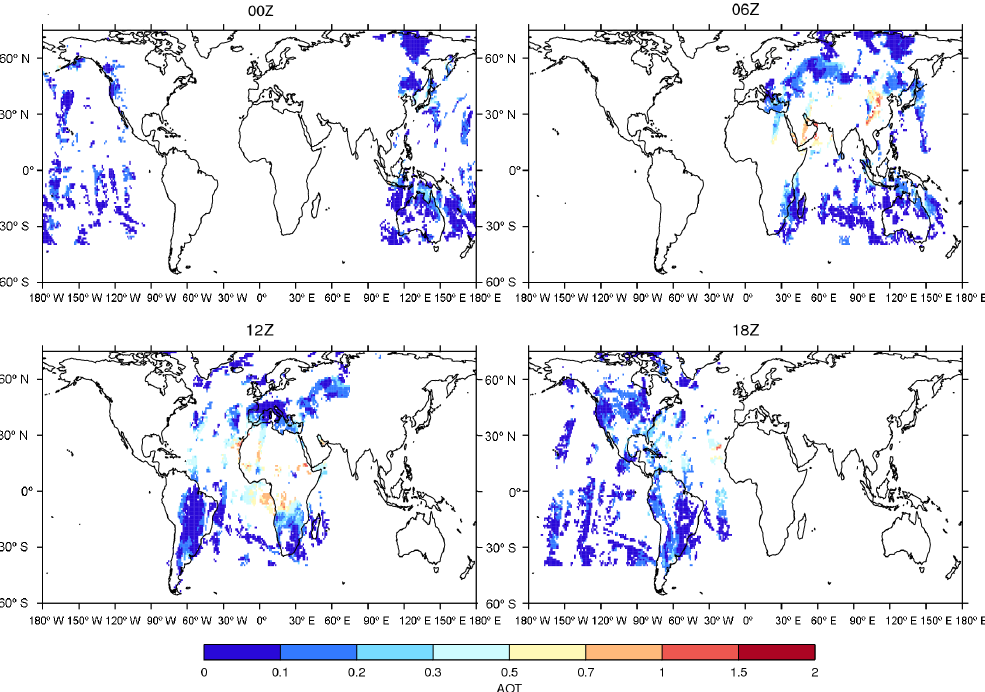
Figure 1. An example of the general pattern of data coverage from MODIS (Aqua + Terra) and MISR for each AOT assimilation cycle at the valid time of the analysis, i.e., 00:00, 06:00, 12:00 and 18:00UTC, in NAVDAS-AOT. The MODIS and MISR AOT data displayed here are after strict QA/QC processes for 11 August 2011. The MODIS and MISR data assimilated in each NAVDAS-AOT cycle were acquired in a 6h range centered on the nominal valid time of the